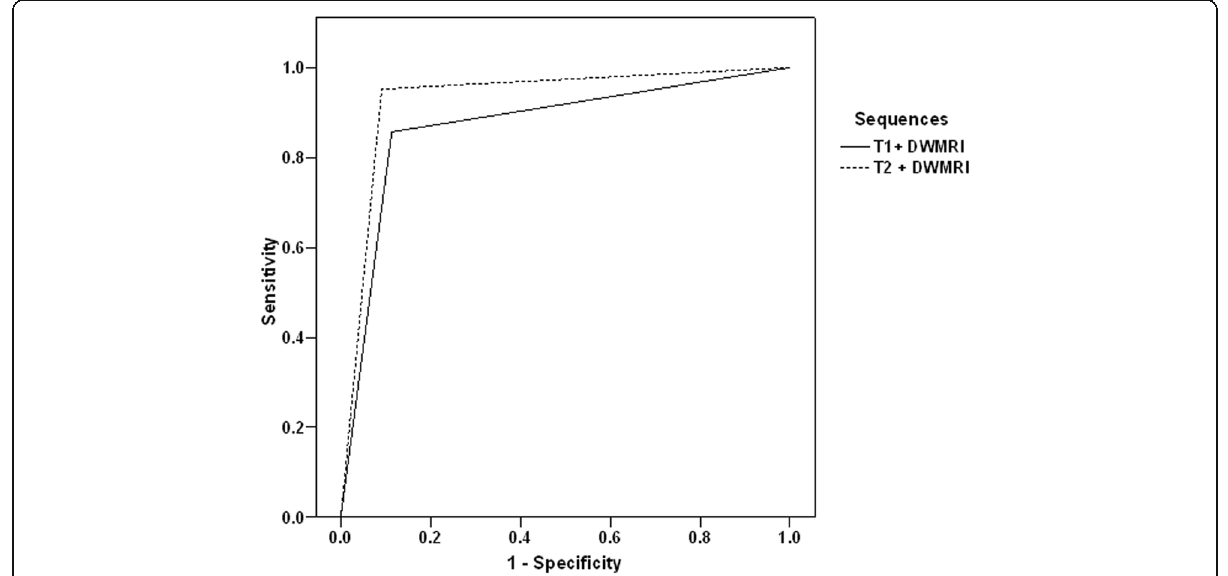
Fig. 4 ROC curve analysis of combinations of MRI sequences for identification of active inflammation of the